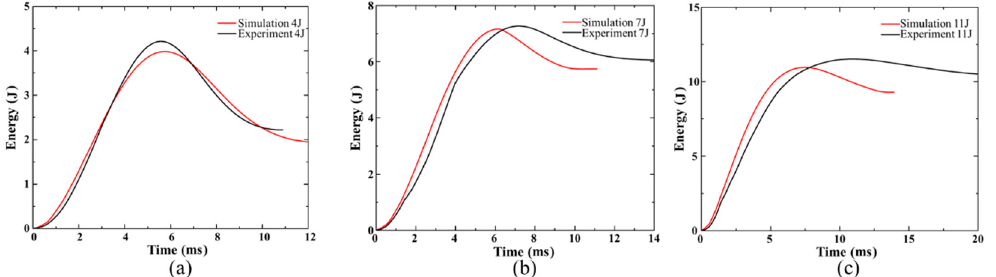
Figure 8. Comparison of numerical and experimental energy–time curves of UACS laminates under impacts ( a ) 4 J, ( b ) 7 J and ( c ) 11 J. impacts ( a ) 4 J, ( b ) 7 J and ( c ) 11 J.